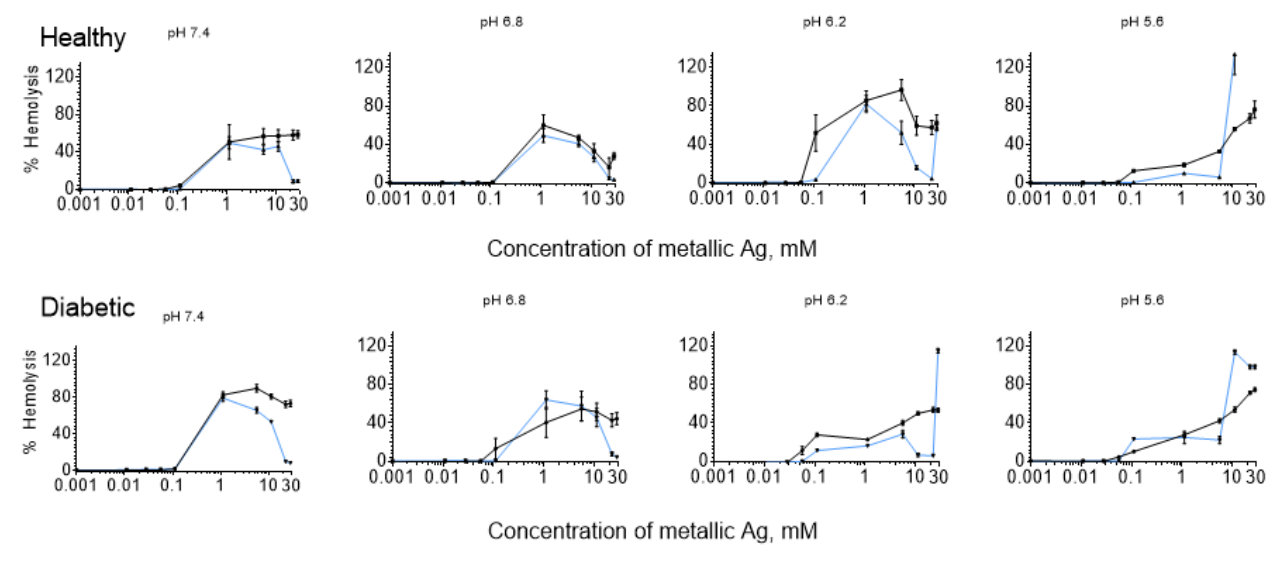
Figure 1. Hemolysis induced by AgNPs and AgNO 3 at different pH for HDE and DDE: AgNPs correspond to blue lines and AgNO 3 to black lines.